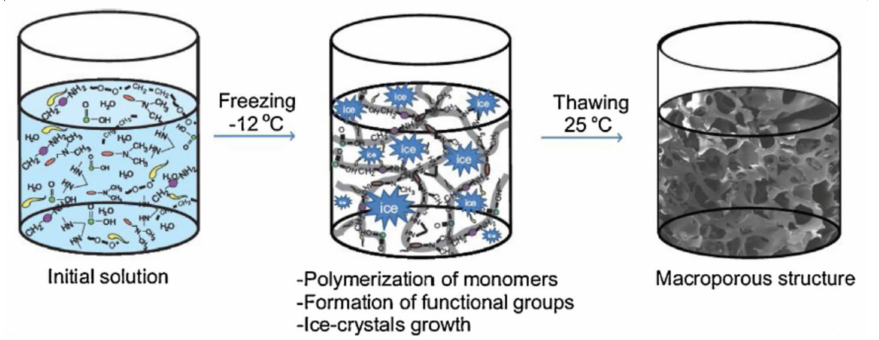
Figure 11. Schematic representation of composite cryogel synthesis (reprinted with permission from ref.